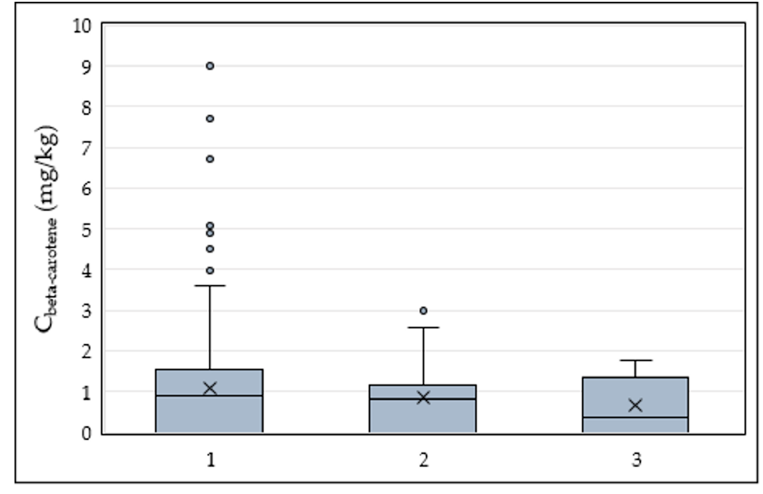
Figure 3. Box and whisker plot presenting the concentration of beta-carotene according to the island of origin. 1—Lesvos ( n = 363), 2—Samos ( n = 51), 3—Ikaria ( n = 12).